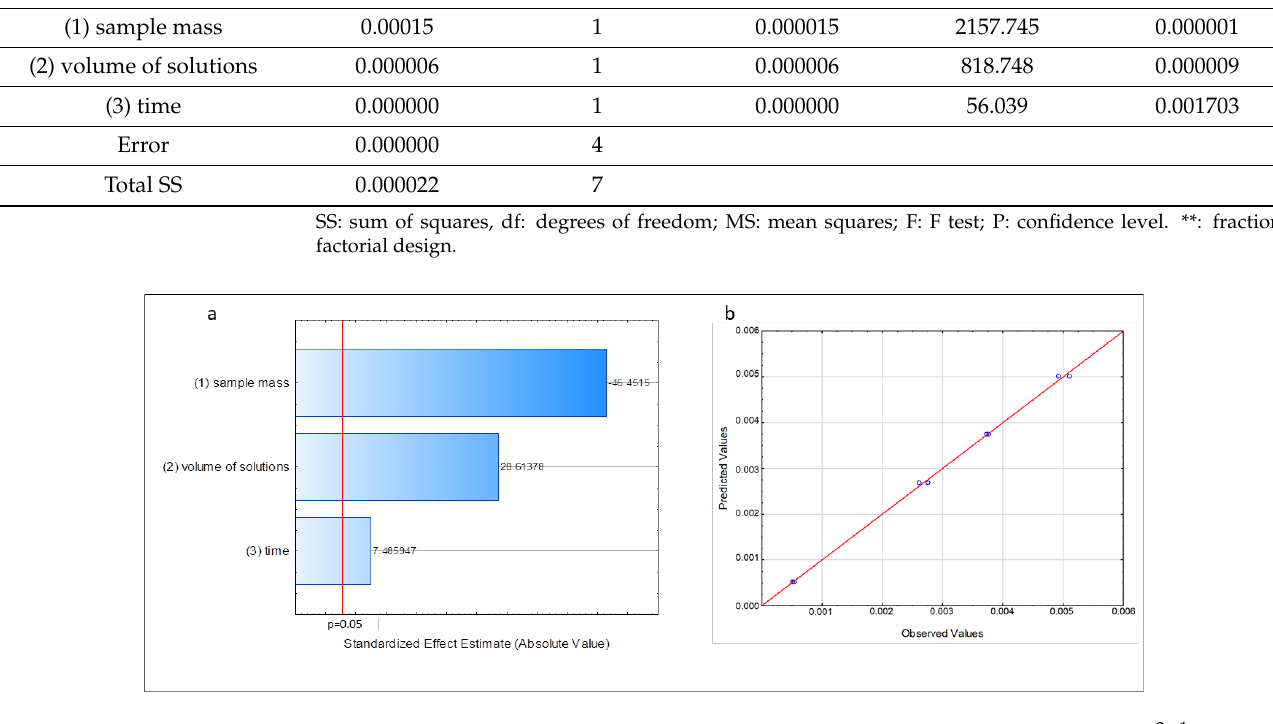
Figure 1. Figures obtained from the model generated by fractional factorial design 2 3 −1 . ( a ) Pareto chart. ( b ) Predicted and observed values for the concentration of DHA. Source: Statistica ® .